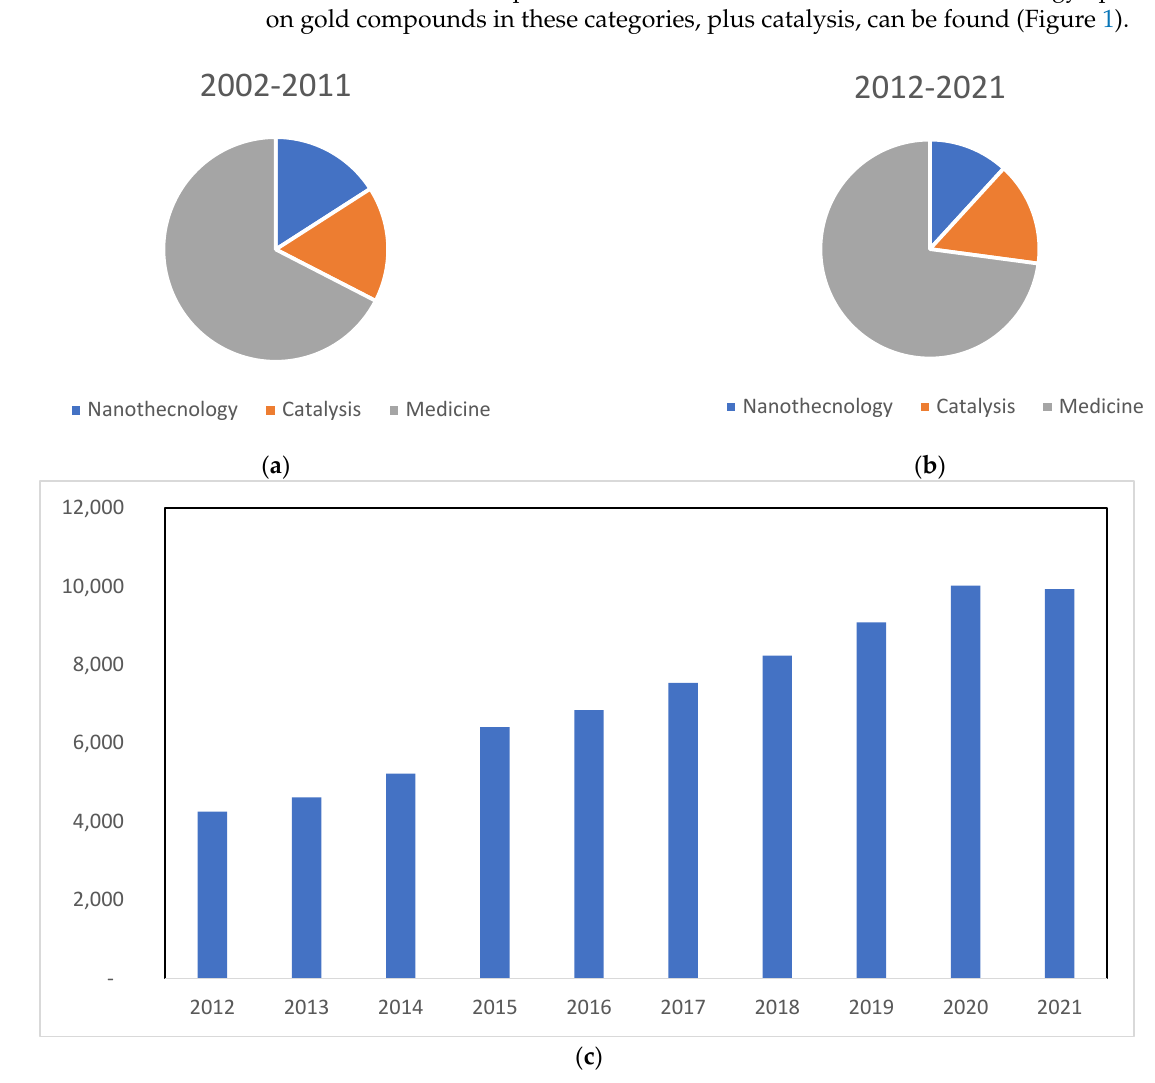
Figure 1. Number of articles indexed on the Web of Science obtained using the keywords "gold compounds” and "nanotechnology", "gold compounds” and "catalysis" and "gold compounds” and "medicine". ( a ) Graph referring to the decade of 2002 – 2011; ( b ) graph referring to the decade of 2012 – 2021; ( c ) graph referring to articles published using gold compounds in medicine from 2012 until now. Review articles were excluded.